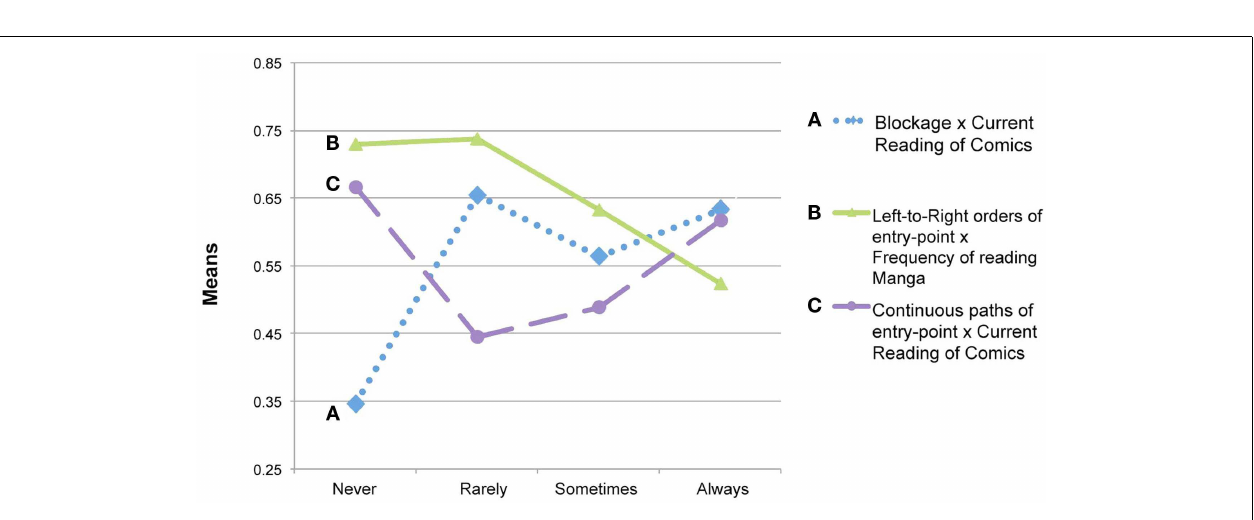
FIGURE 5 | Influence of background expertise on various strategies of navigating page